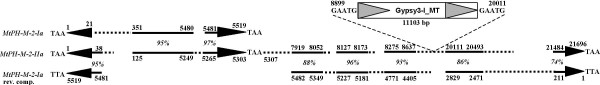
Mosaic structure of the MtPH-M-2-IIa element, as compared to the core element MtPH-M-2-Ia. Solid lines represent homologous regions with similarity rates written in italics, dotted lines represent regions with no homology, numbers in bold show the localization of nucleotide positions of important features, a nested retrotransposon is drawn above the AC149306 element.